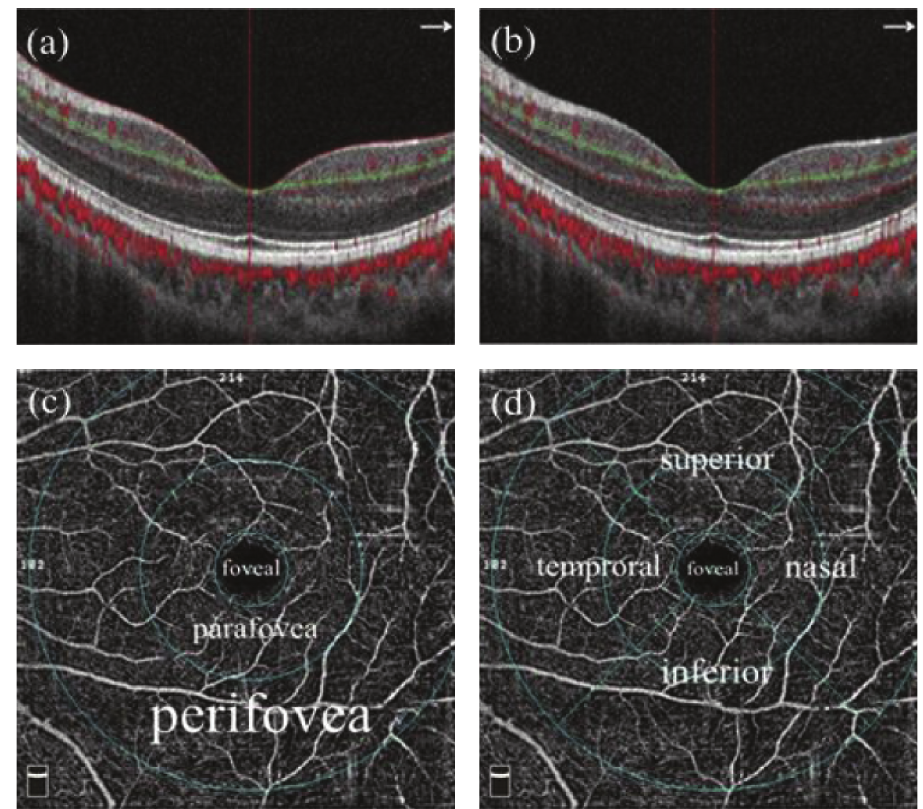
Figure 1: Pictorial representation of the macular capillary plexus. (a), (b) Superficial capillary plexus (SCP) and deep capillary plexus (DCP), respectively. (c) Three circles with different radii, including foveal regions, parafoveal regions, and perifoveal regions. (d) Superior, inferior, nasal, and temporal quadrants. Table 1: Demographic and ocular characteristics of participants between the three diagnostic